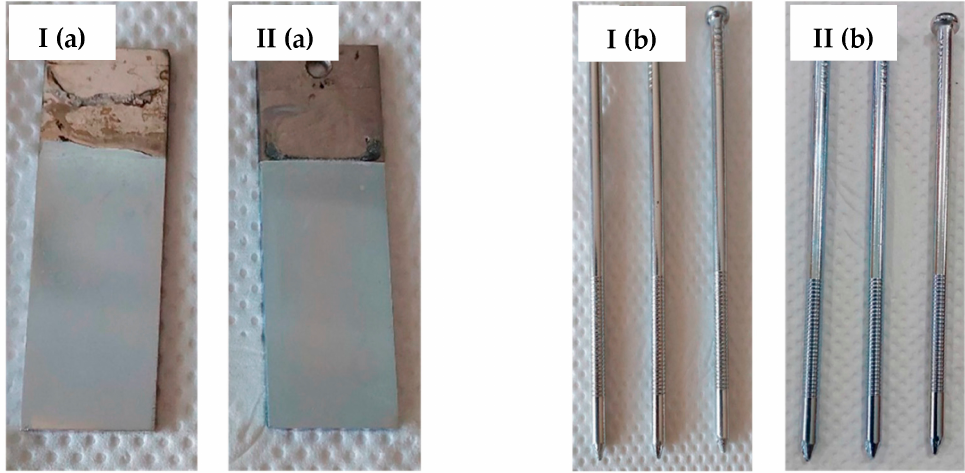
Figure 4. Appearance of zinc coating deposited on a flat carbon steel substrate ( a ) and industrial details ( b ) from baths prepared on the basis of the RO retentate ( I ) and tap water ( II ). The images confirm the validity of the parameters established in the Hull cell study.